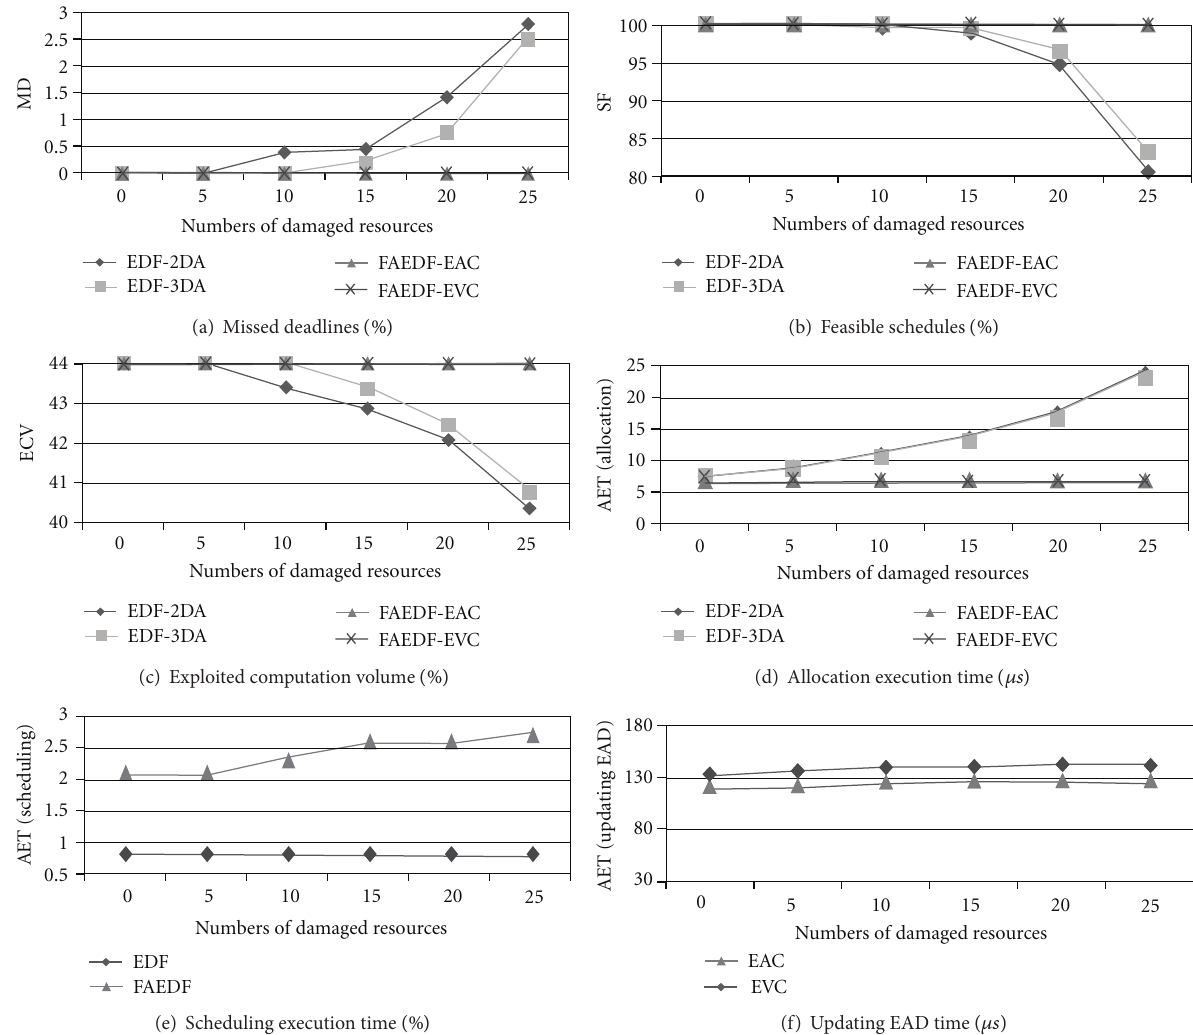
= 0.9 and 𝑈 = 0.5 ICAP COMP